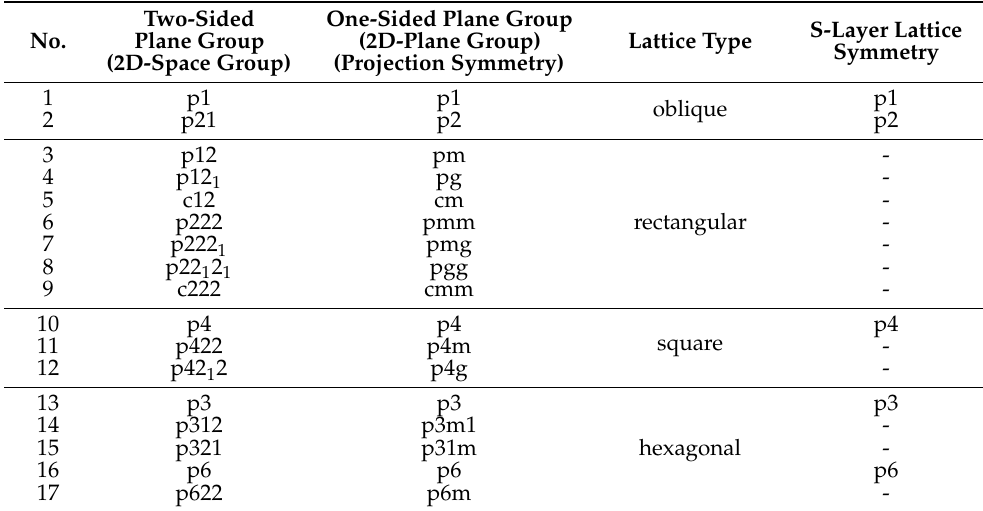
Table 1. The 17 two-sided plane groups allowed for biological molecules. These contain no mirror or glide planes or inversion centers [1]. The nomenclature of Holser is used [64]. The symbols are written in the following sequence: (1) Cell type indicated by a small letter, p (primitive) or c (centered), (2) axis perpendicular to the plane, arbitrarily chosen as the z -axis, (3) symmetry in the plane, along an axis designated x, and (4) symmetry in another direction in the plane.